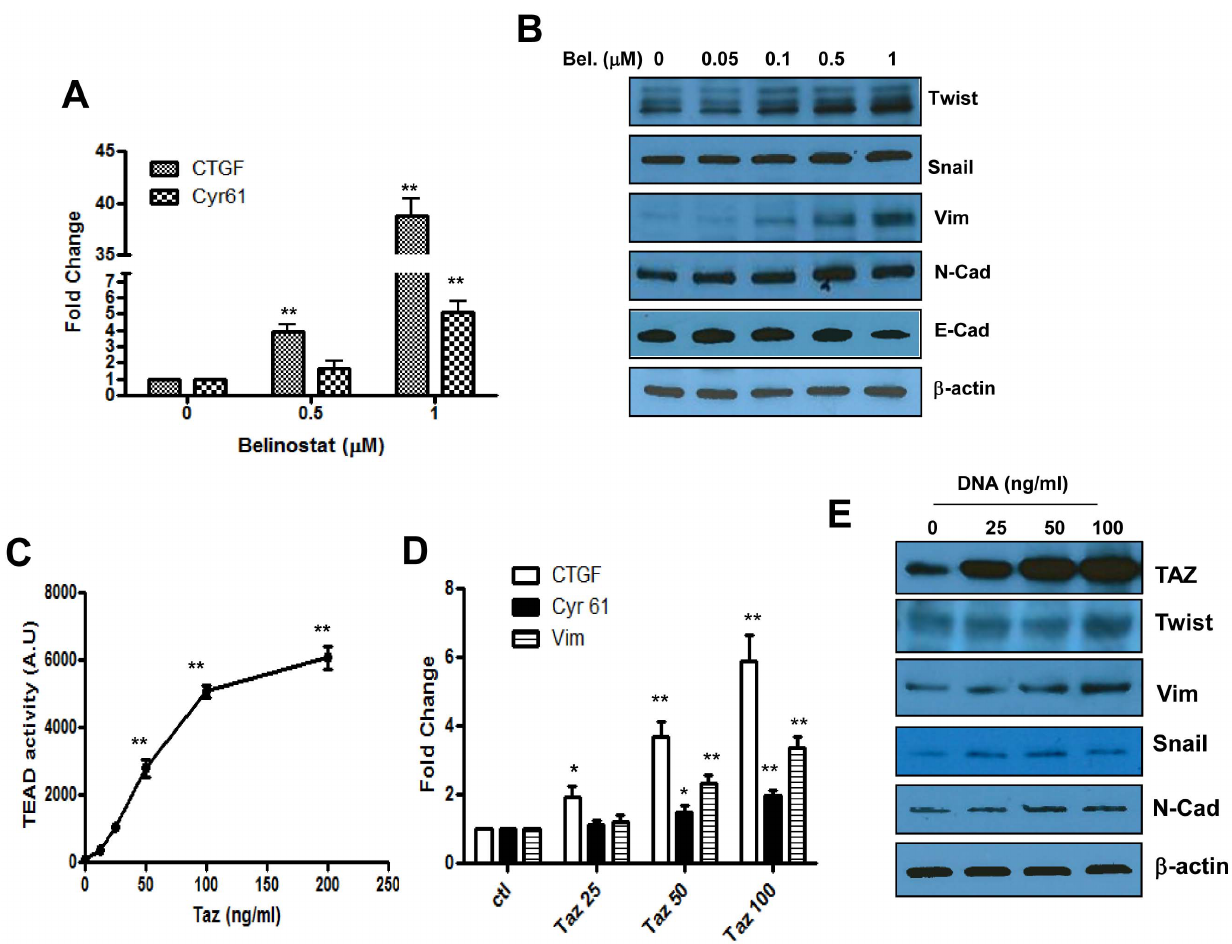
Figure 2. Regulation of Hippo downstream genes by Belinostat and role of TAZ in mediating these effects. Panel A. Expression of TAZ target genes CTGF and Cyr61 measured by Q-PCR in the absence or the presence of Belinostat at the indicated concentrations ( m M). Panel B. Representative Western blots showing the expression of EMT genes in response to Belinostat in SW480 cells (Ecad: E Cadherin, N-Cad: N cadherin). Panel C. Effect of TAZ gene overexpression on activity of the Hippo reporter. SW480 cells were transfected with the TAZ DNA construct at the indicated concentrations and activity of luciferase reporter measured after 24 hrs. Panel D. Effect of TAZ overexpression on expression of its downstream target genes. Cells were transfected by TAZ as described in panel C and expression of CTGF and Cyr 61 and Vimentin (Vim) was measured by Q-PCR. Panel E. Representative Western blots showing expression of EMT associated genes in response to TAZ overexpression (Vim: Vimentin, N-Cad: N cadherin). Data in panels A, C and D, represent average of three determinations 6 SE. Statistical significance is shown for drug- treated or TAZ-transfected cells compared to the corresponding controls (*p , 0.05, **p , 0.001).